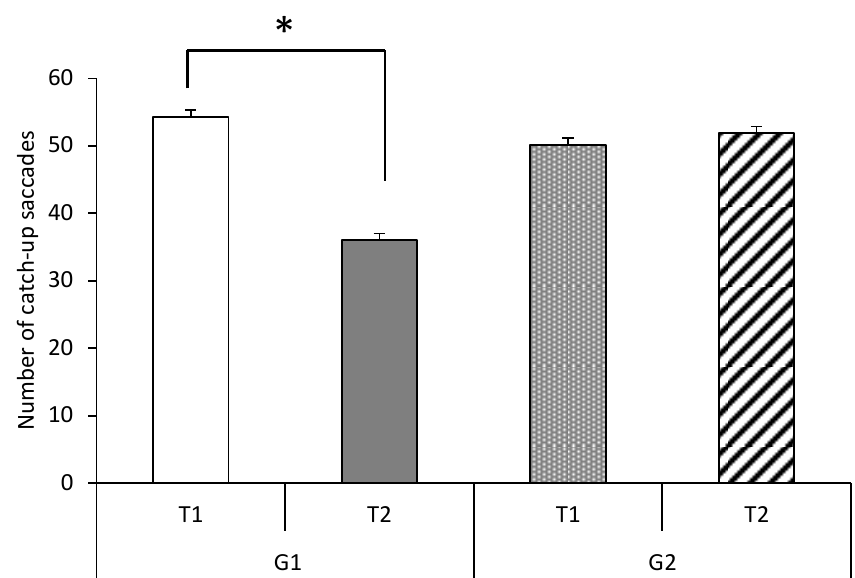
Figure 3. Number of catch-up saccades for children with ADHD. G1 is the interventional group and G2 , the non-interventional group. They were both tested 2 times at inclusion ( T1 ) and after the short rehabilitation training for G1 or a resting time for G2 ( T2 ). *: p < 0.05.